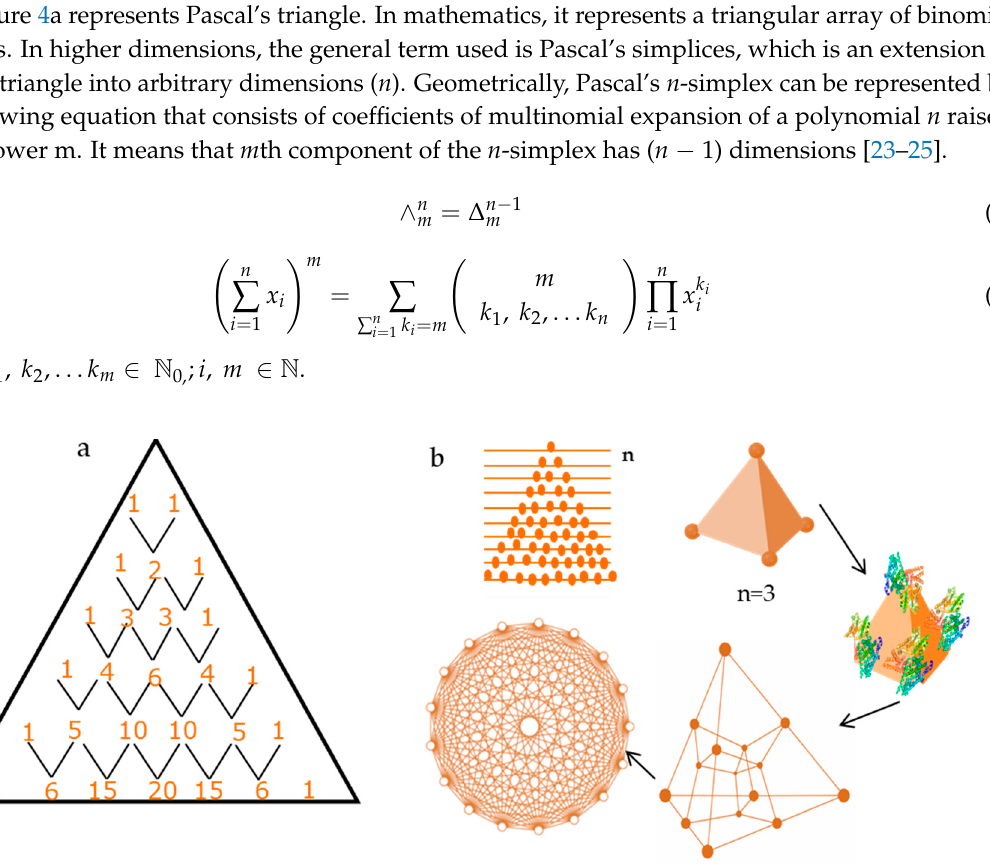
Figure 4. Diagram showing connection of Pascal’s triangle to geometric design: ( a ) illustration of Pascal’s Triangle and ( b ) Sketch of Pascal’s triangle and n -simplex when n = 3, representing a tetrahedron structure, when tetrahedron structures join together symmetrically into a 120-cell unit it gives a 2-D projection or symmetric unit which resembles the ring pattern.